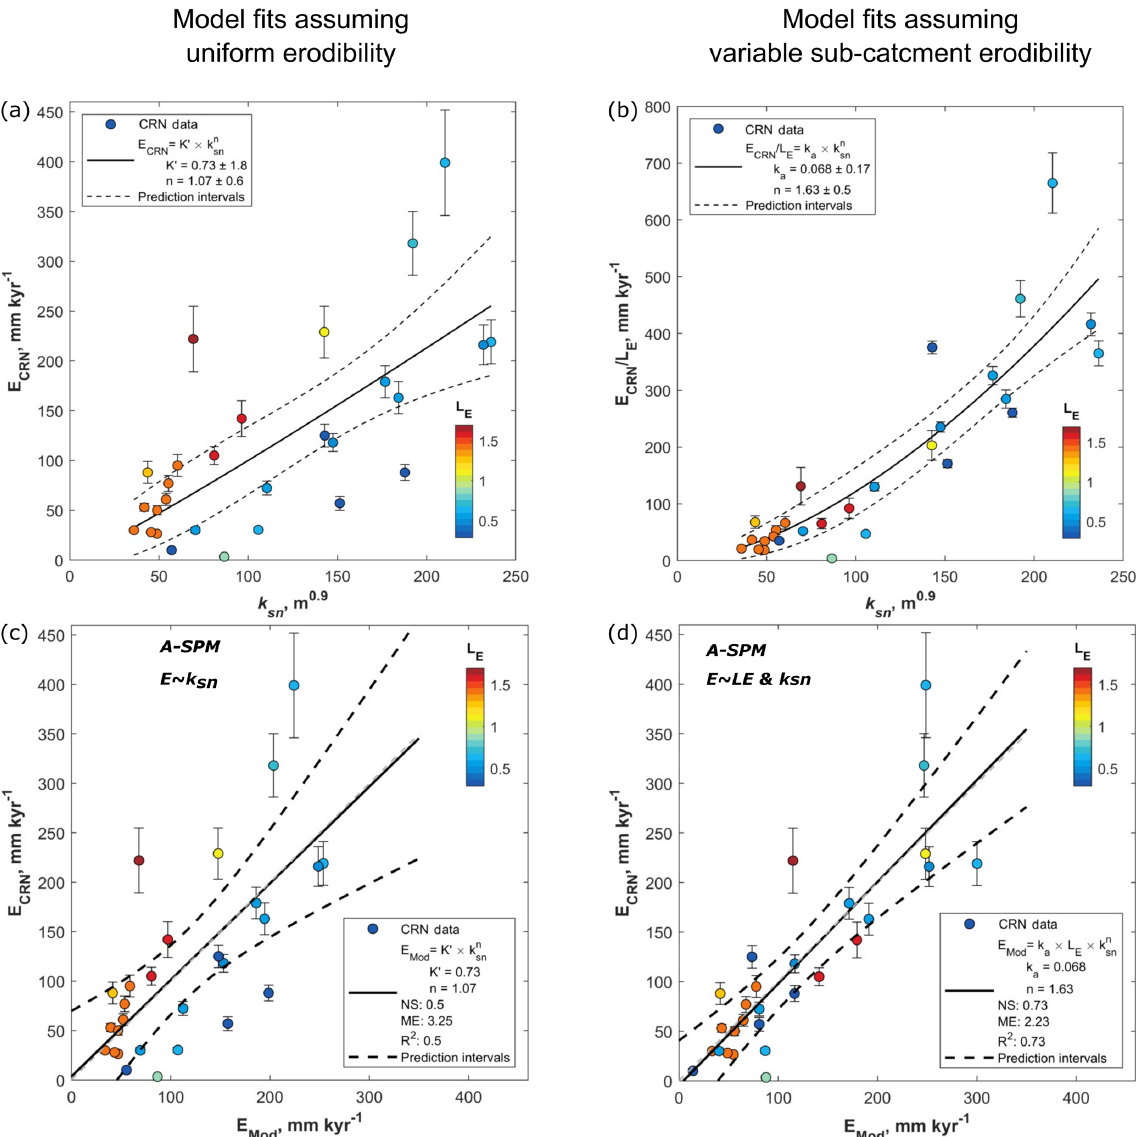
Figure 7. Best fit between CRN-derived erosion rates ( E CRN ) and river steepness index ( k sn ) or modeled river incision ( E Mod ) using the Area-Based Stream Power Model (A-SPM). (a) Measured E CRN versus k sn (Table 2). Observations are colored according to the average lithological erodibility of the sub-catchment ( L E ). Low values for L E represent strong rocks that are resistant to erosion. High values for L E represent weak rocks that are susceptible to erosion. (b) Measured E CRN divided by L E versus k sn (Table 2). By correcting the E CRN values for lithological heterogeneity, the k sn − E CRN relationship becomes significantly nonlinear ( n = 1 . 63 ± 0 . 5). (c) A-SPM scenario 1 (see Table 4). Modeled erosion rates for catchments consisting of strong rocks (blue) are mostly overpredicted and plot below the 1 : 1 line. Modeled erosion rates for catchments consisting of weak rocks (red) are mostly underpredicted and plot above the 1 : 1 line. (d) A-SPM scenario 2 (Table 4) in which spatially variable lithological erodibility is explicitly accounted for. A complete overview of all best model fits for A-SPM scenarios 1–4 is given in Fig.